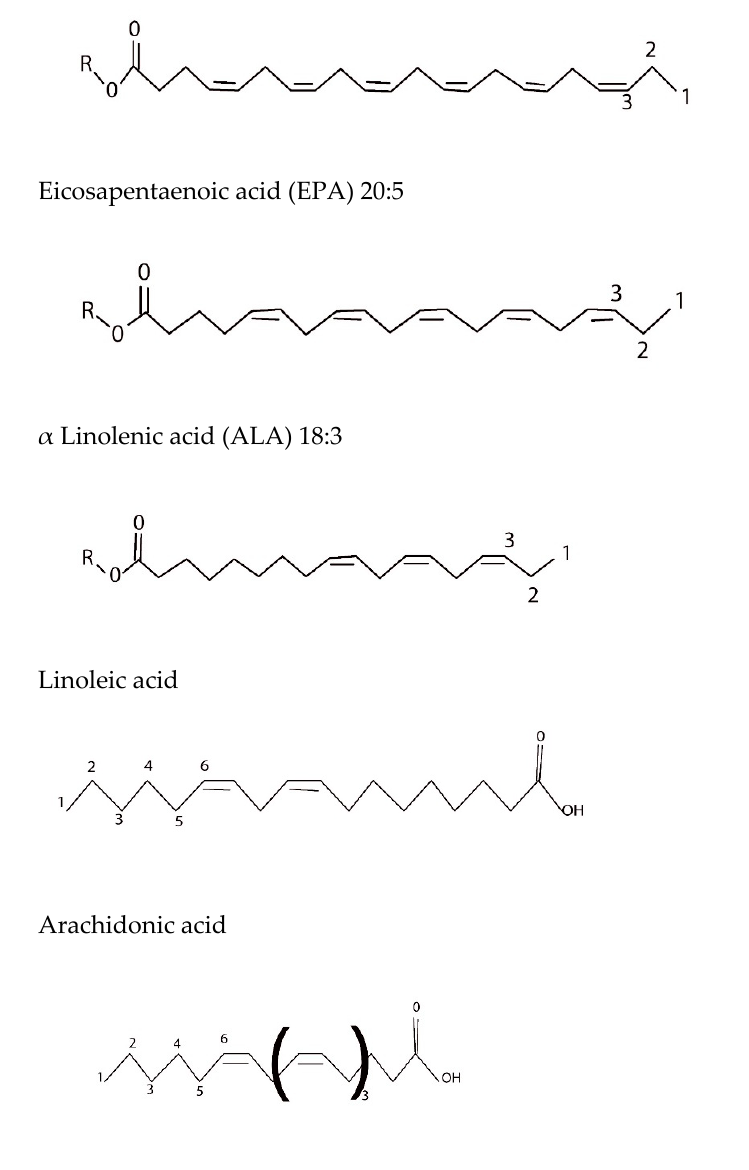
Figure 1. Structures of n-3 and n-6 fatty acids.